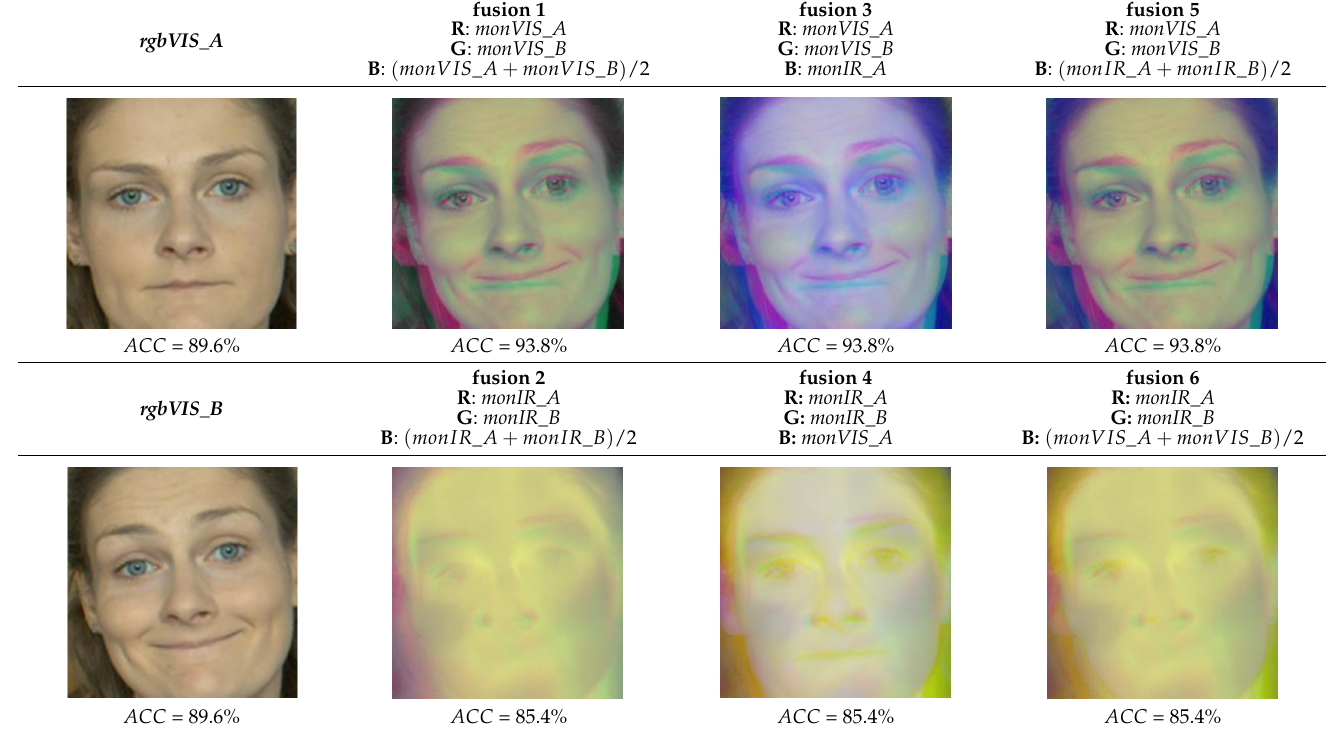
Table 3. Examples of RGB class images used as AlexNet input.